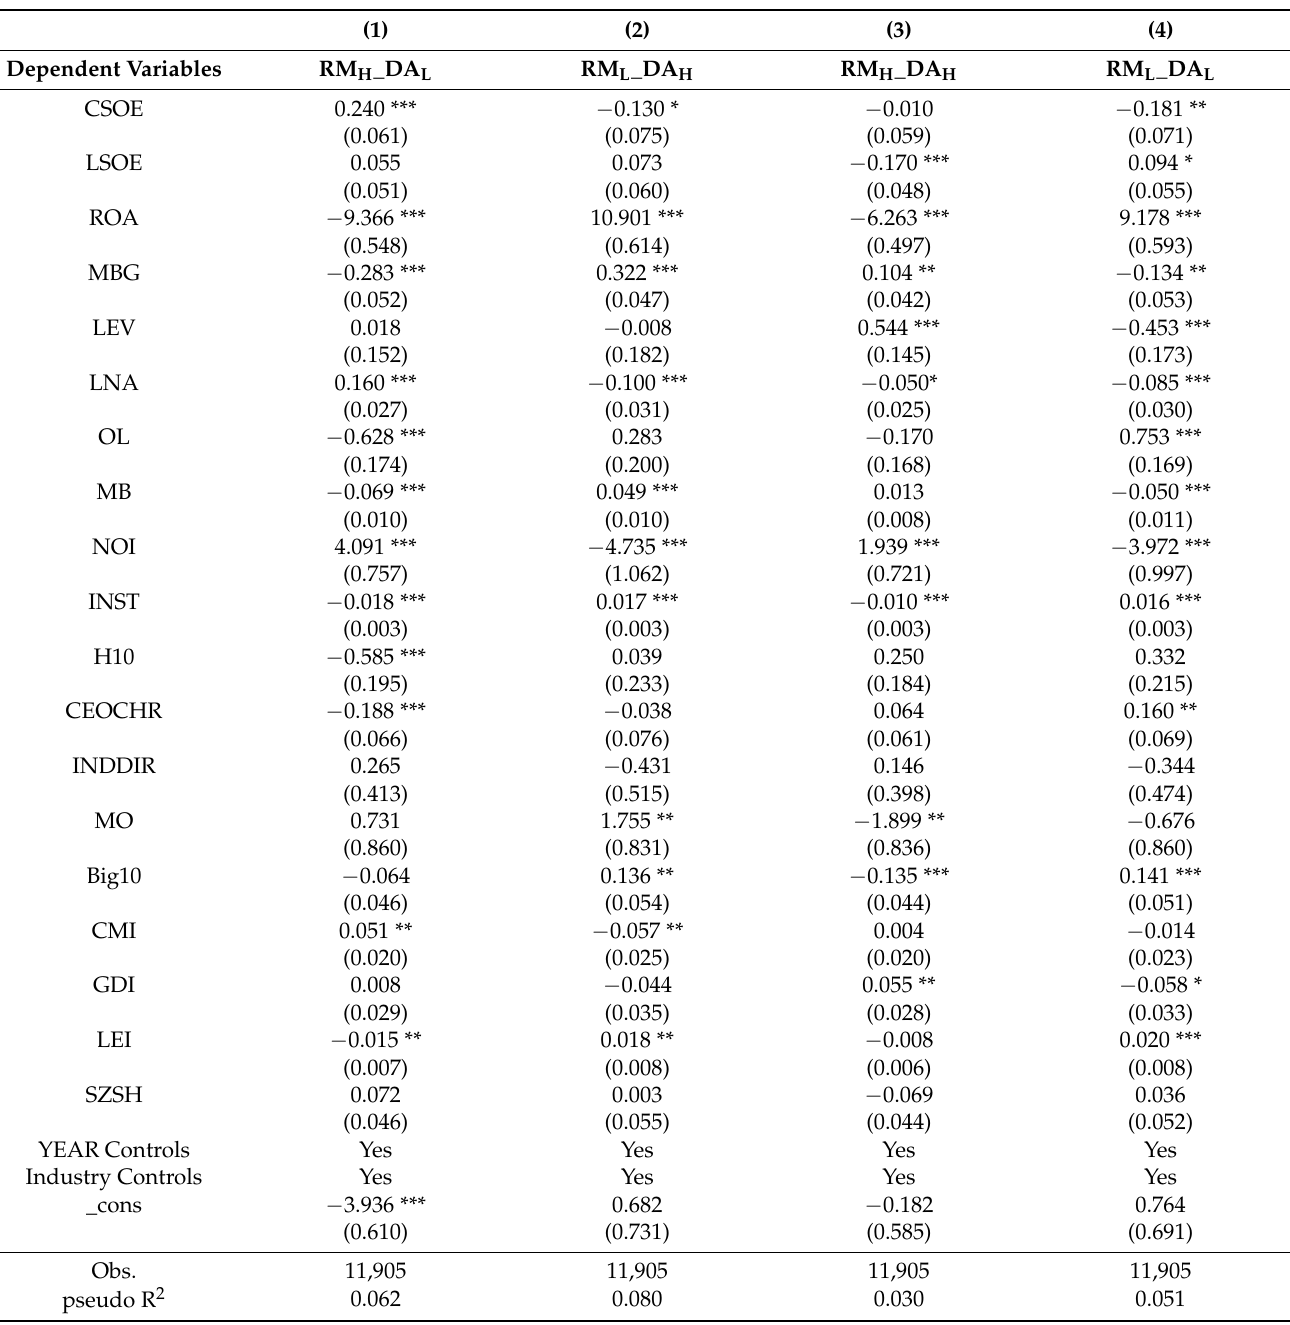
Table 8. The Effect of State Ownership Type on Earnings Management Combination